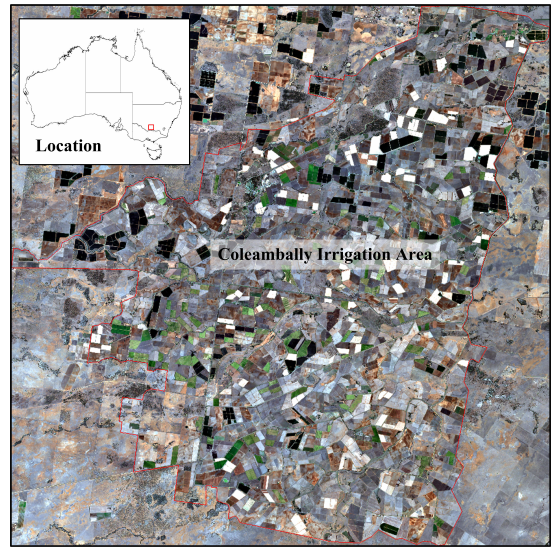
Figure 3. Location and color composite map (R: Band 4; G: Band 3; B: Band 2) of the study